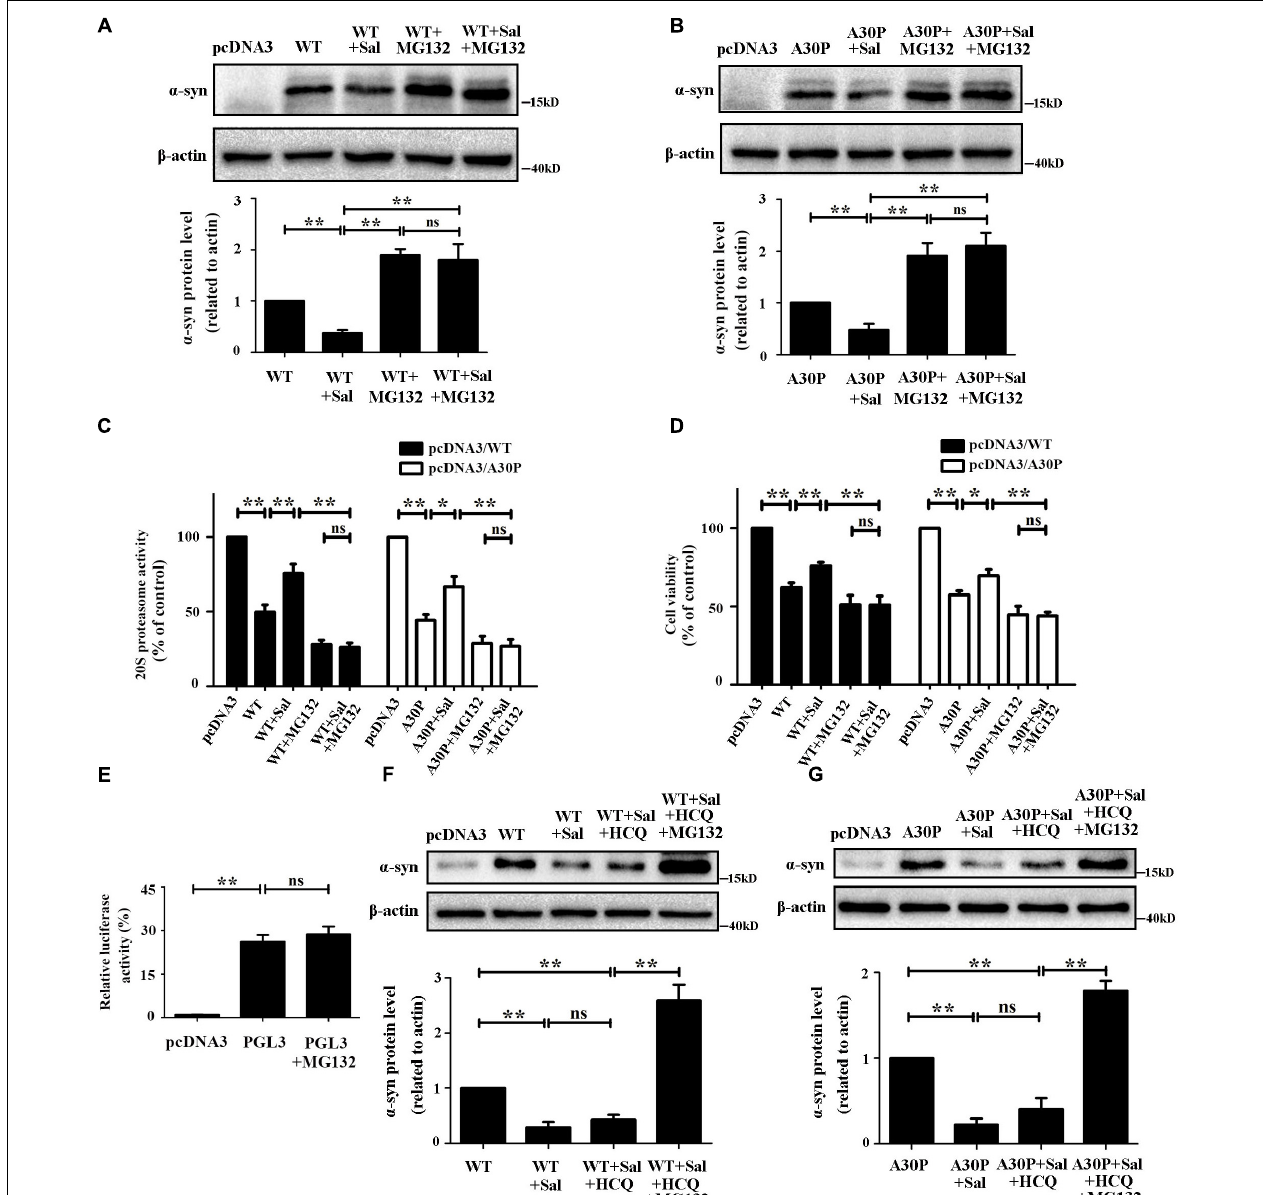
FIGURE 6 | Sal protected cells and promoted α -syn clearance by enhancing 20S proteasome activity in WT/A30P- α -syn-transfected cells. SH-SY5Y cells were transfected with WT/A30P- α -syn for 24 h after which Sal (40 µ M) was added for an additional 24 h in the presence or absence of MG132. (A,B) Immunoblot levels of WT/A30P- α -syn in SH-SY5Y cells. (C) Proteasome activity assay analysis of 20S proteasome activity. (D) MTT assay analysis of cell viability in SH-SY5Y cells. (E) Luciferase reporter gene assay. SH-SY5Y cells were transfected with pcDNA3 vector and PGL3 for 24 h, then the cells treated with MG132 (0.25 µ M) or DMSO for another 24 h. (F,G) Western blot analysis of WT/A30P- α -syn protein levels in SH-SY5Y cells. Cells were transfected with WT/A30P- α -syn for 24 h after which Sal (40 µ M) was added for an additional 24 h in the presence or absence of HCQ, HCQ, and MG132. Statistical significance was analyzed by one-way analysis of variance (ANOVA). A two-tailed Student’s t -test was performed for comparisons between two groups. Data are shown as the mean ± SEM. Each experiment was repeated three times independently. ∗ P < 0.05; ∗∗ P < 0.01, ns: no significance.